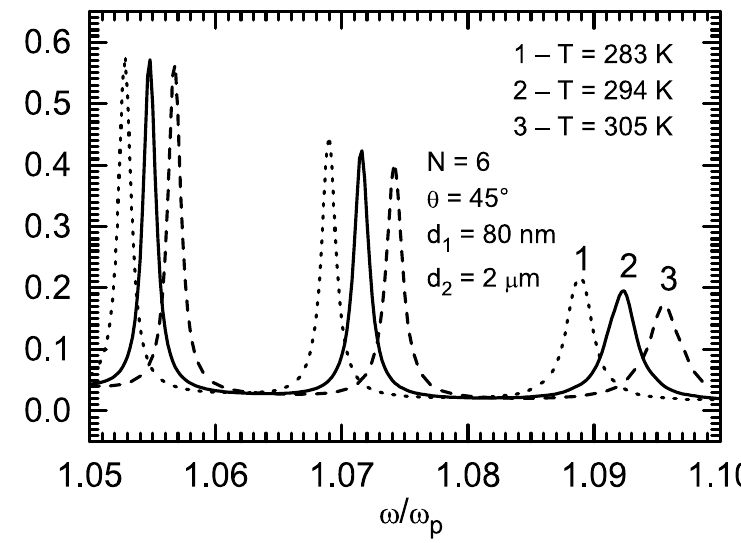
Figure 6. Absorptance A as a function of the relative frequency ω / ω p for the quantum electron plasma at the graphite layer number N = 6, incidence angle θ = 45 ◦ , graphite layer thickness d 1 = 80 nm, and quartz layer thickness d 2 = 2 µ m, for various temperatures: 1 − T = 283 K (dotted line), 2 − T = 294 K (solid line); 3 − T = 305 K (dashed